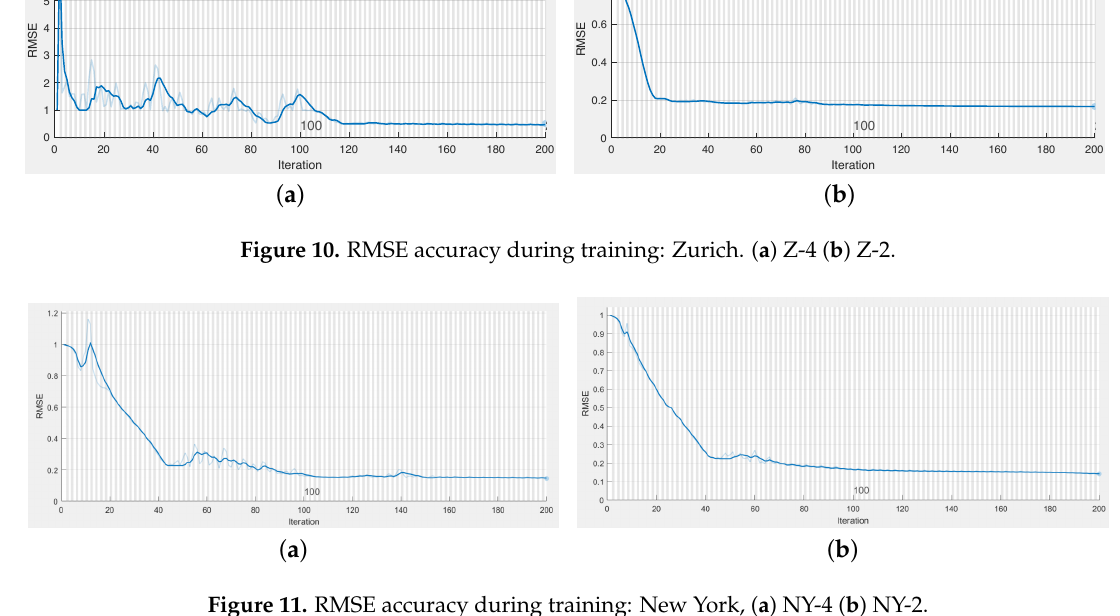
Figure 11. RMSE accuracy during training: New York, ( a ) NY-4 ( b )